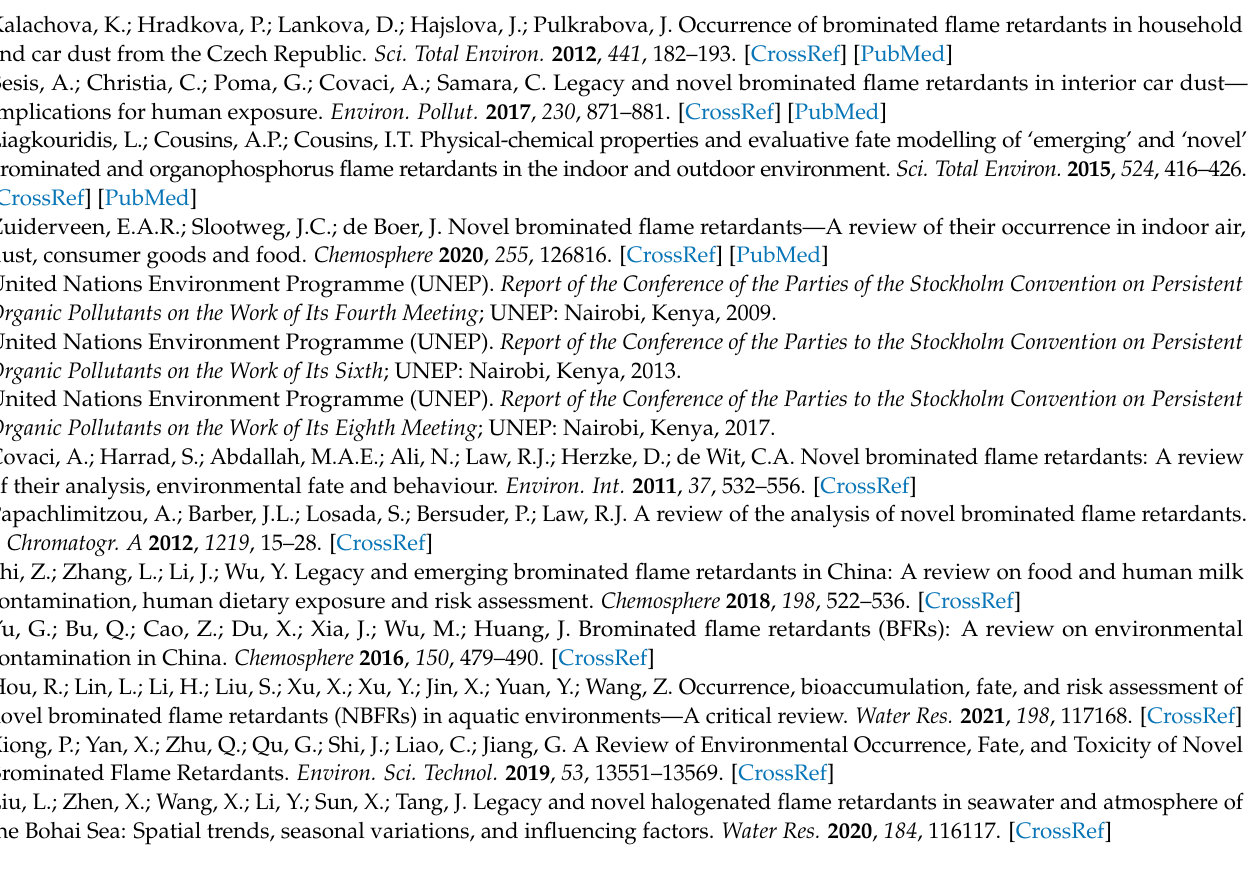
pathway; Table S7. The estimated daily intake of NBFRs and HBCDs via dust inhalation pathway; Table S8. The estimated daily intake of NBFRs and HBCDs via dust dermal contact pathway; Table